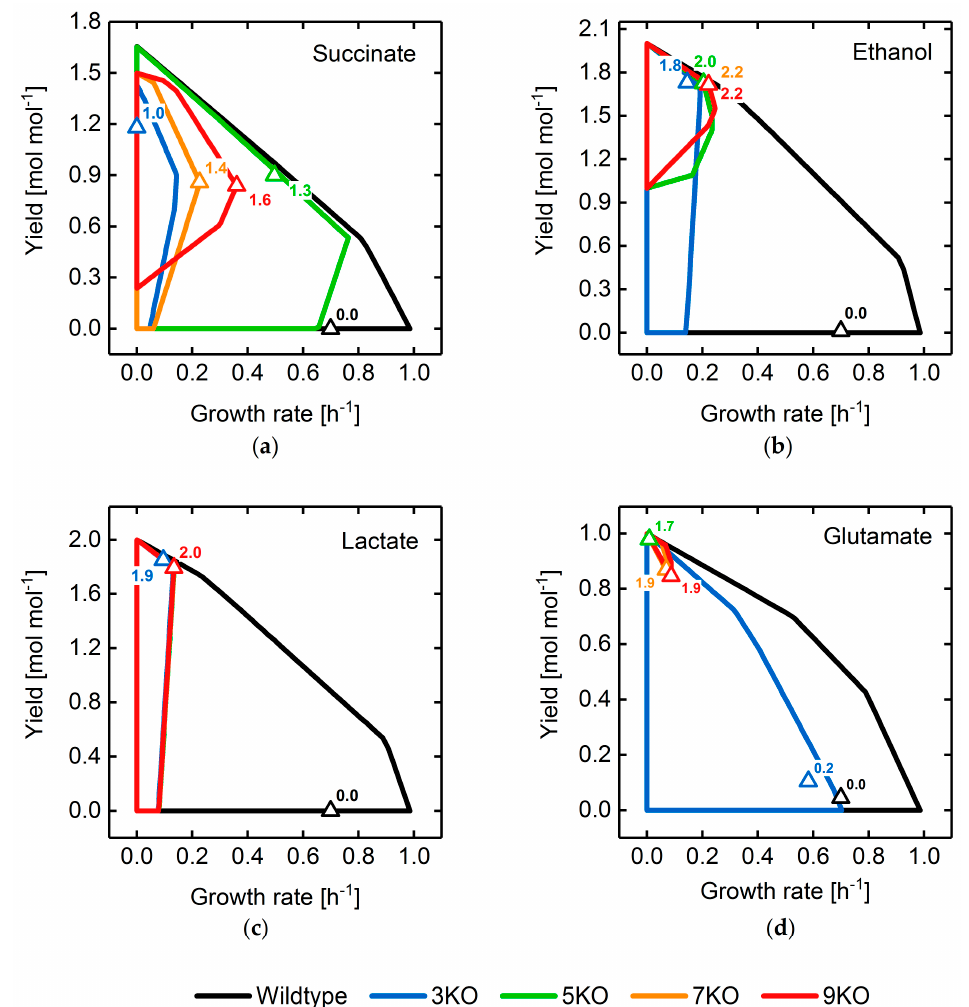
Figure 11. Yield spaces of wild-type, as well as mutant, E. coli strains optimized for the overproduction of succinate ( a ), ethanol ( b ), lactate ( c ), and glutamate ( d ) using a combination of BPCY, growth-coupling, and production rate at maximal growth rate as the engineering objective. All mutant yield spaces are based on the substrate uptake rate predicted by MiMBl. Triangles and attached numbers illustrate the phenotype prediction calculated by MiMBl and the fitness value for a strain design with a given number of reaction deletions, respectively. Refer to the Supplementary Section I.2 for a brief description of yield space calculations.